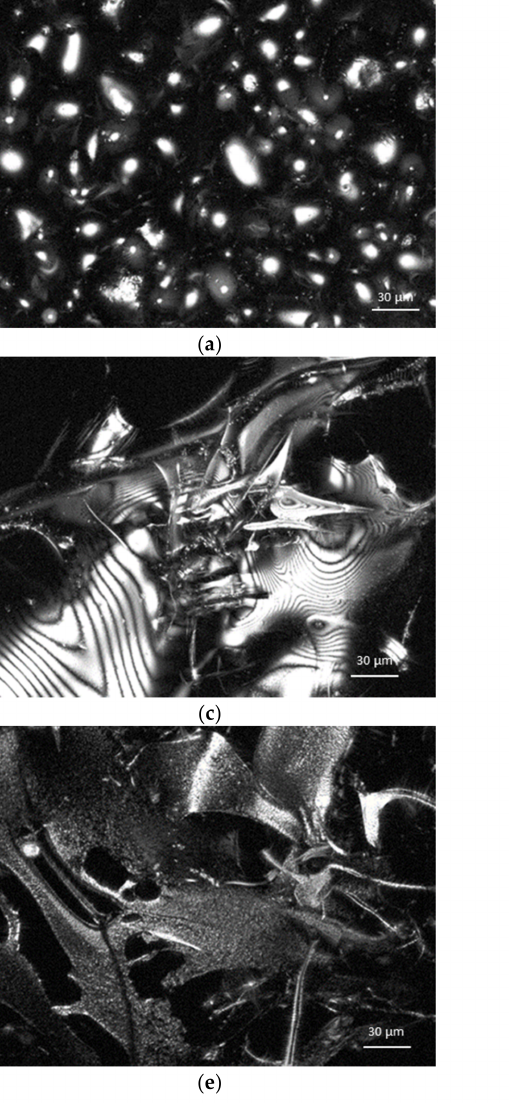
Figure 6. Laser scanning microscopy (LSM) images of ( a ) native potato starch; ( b ) carbon spheres aggregates; ( c ) PAM; ( d ) starch grafted polyacrylamide hybrid with the St:AM molar ratio of 1:3 and 1 wt.% of CSs (St-3PAM-1CS); ( e ) polymer hybrid with the St:AM molar ratio of 1:5 and 1 wt.% of CSs (St-5PAM-1CS); and ( f ) polymer hybrid with the St:AM molar ratio of 1:3 and 3 wt.% of CSs